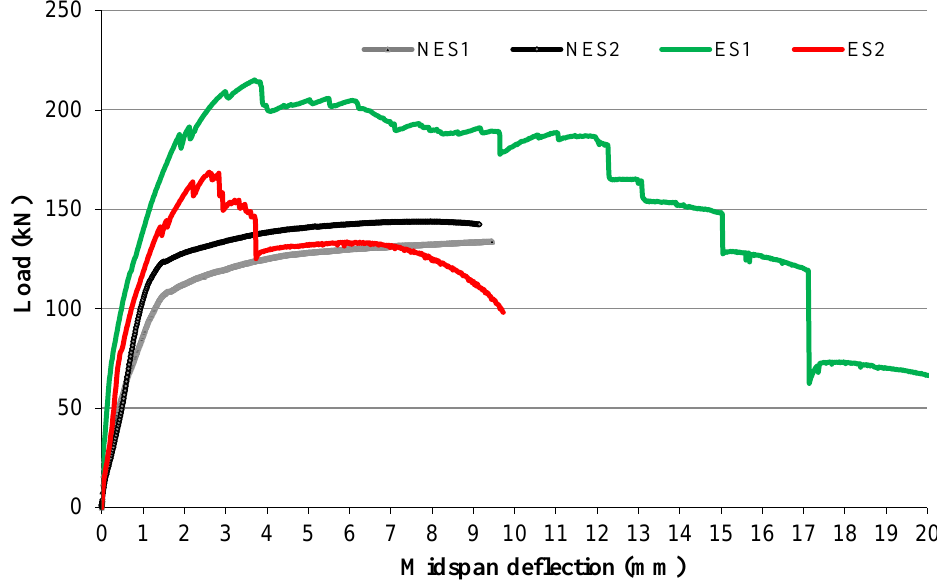
( b ) Figure 7. Observed failure modes of strengthened beams: ( a ) specimen ES1 (CFRP bonded without